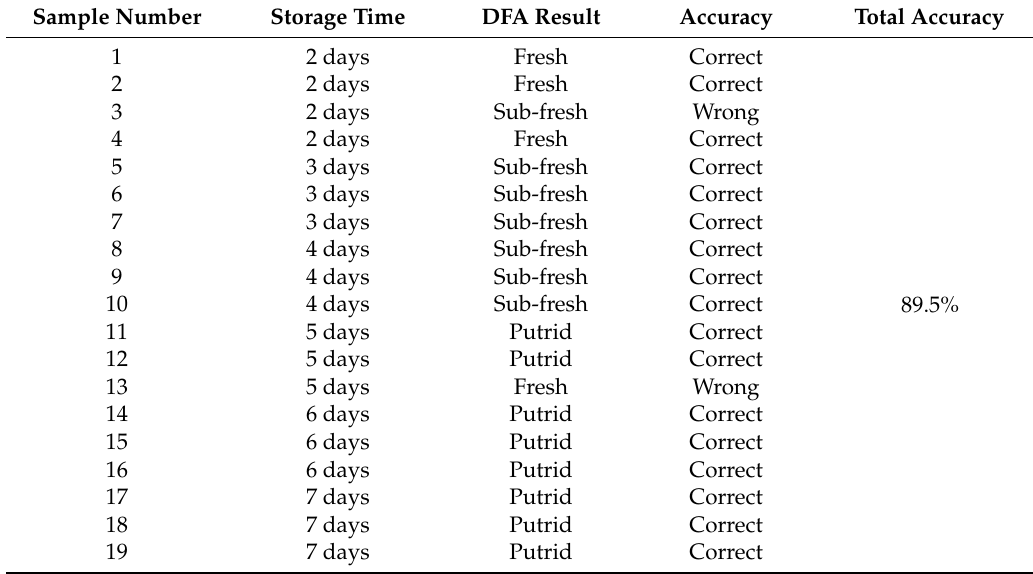
Table 3. DFA result of 19 unknown pork samples.